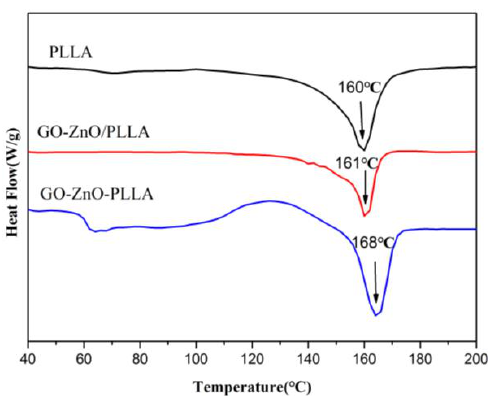
Figure 6. Differential scanning calorimetry (DSC) curves of PLLA and its composites.